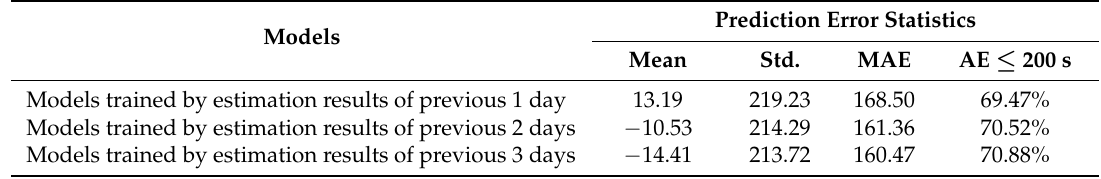
Table 5. Comparison of the prediction errors from NAR ( 2 ) trained using different data.